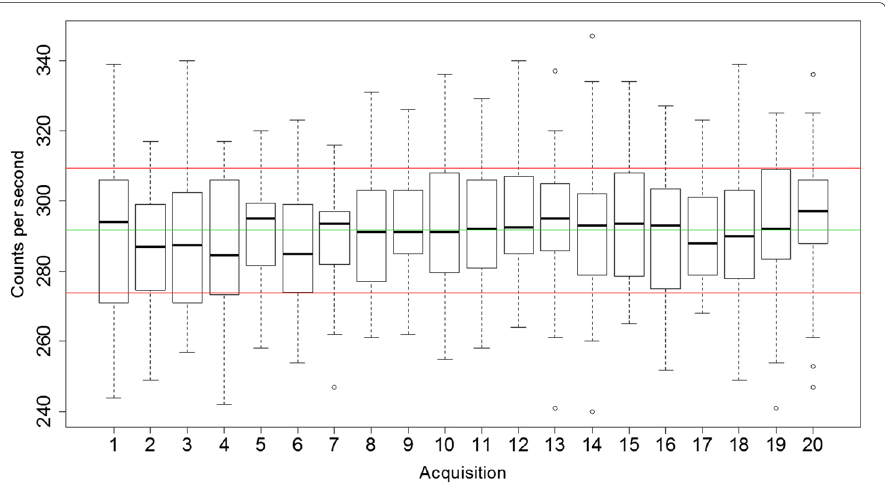
Fig. 11 Box-and-whisker plot representation of twenty successive repositioning of the catheter, which is kept in place by a 3D-printed piece. The greenline represents the mean value of all data and the redline represents one standard deviation from the